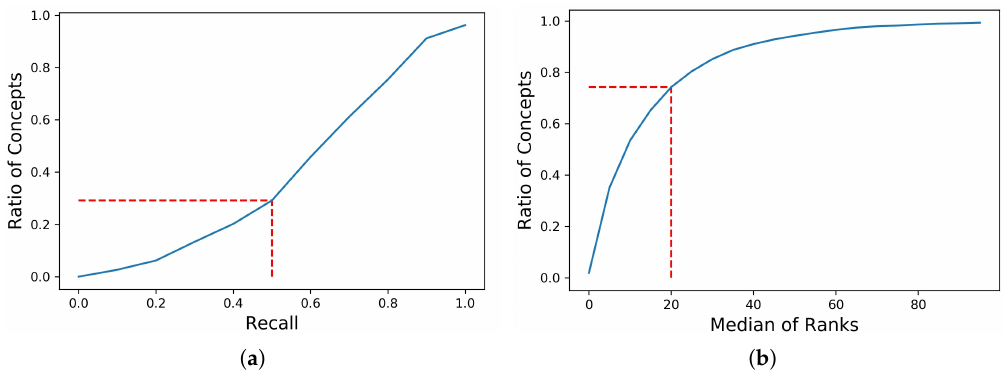
Figure 14. The image recognition results when the recognition targets were the 3585 visual geospatial concepts w p which was actually attached to at least 5 test images. ( a ) Cumulative distribution of recall rates. ( b ) Cumulative distribution of median